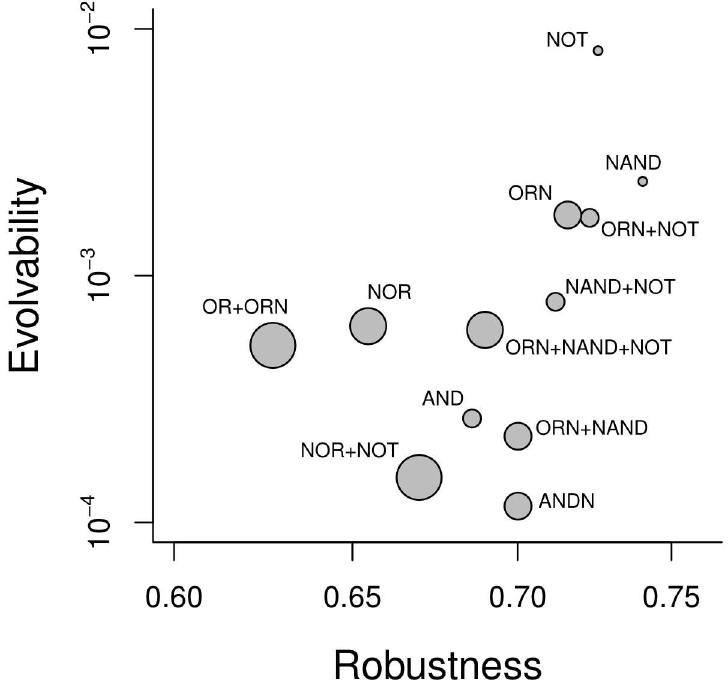
Fig 4. Phenotypic evolvability increaseswith phenotypic robustness. We computedthe robustness of phenotype i as the fraction of 1-mutant neighborswith the same phenotype as i , averaged over the 1000 genotypes with phenotype i . We computedthe evolvabilityof phenotype i as the fraction of the phenotype space that occur in the 1-mutant neighborhood of 1000 genotypes with phenotype i , multipliedby the frequency of phenotype i . Only those phenotypes where we have frequency data are consideredin this figure. Text labels indicatethe logic functions that define each phenotype. The diameter of the circles is proportional to phenotypic